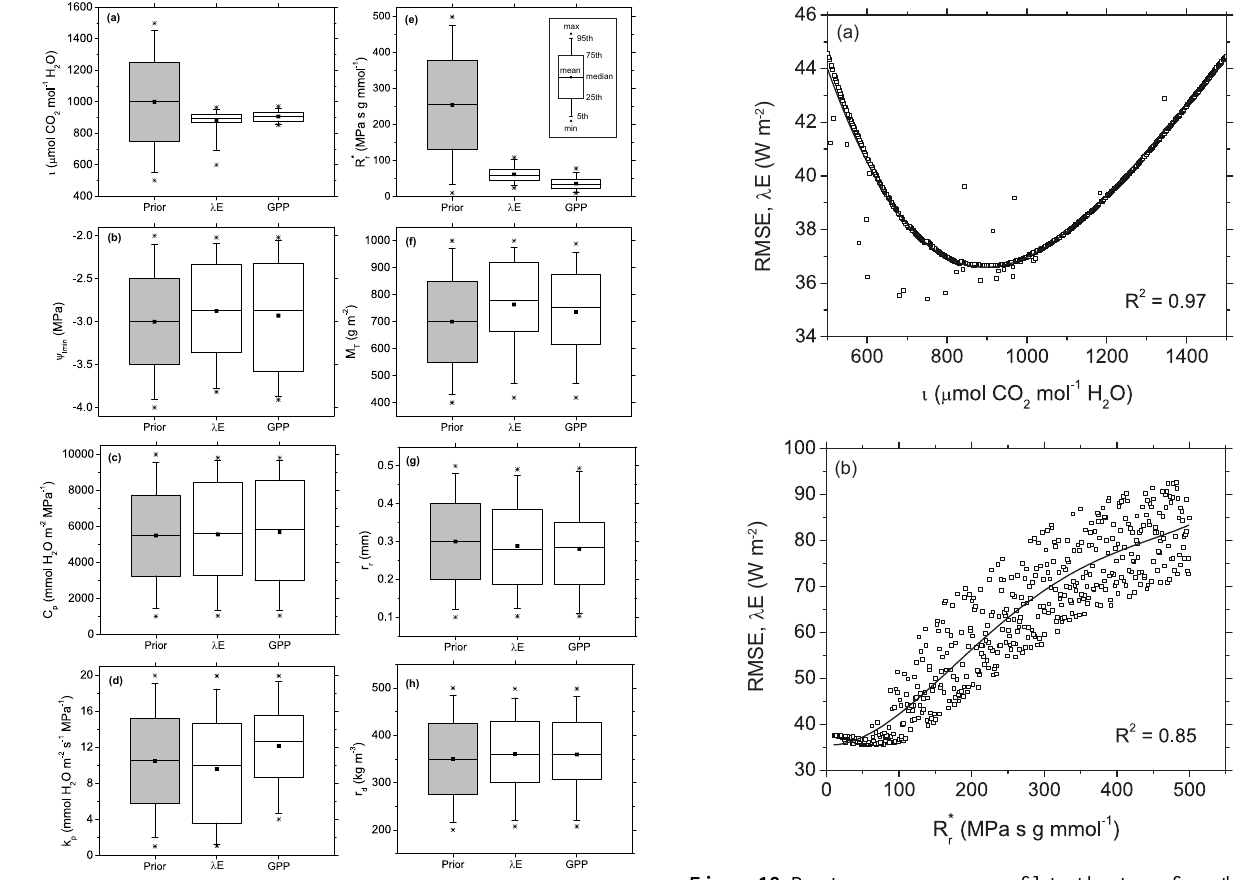
Figure 17. As in Fig. 15, but for SPA-WUE optimization. Parame- ters were generated from latin hypercube sampling ( m = 500 points with n = 4 variables). The left-hand panels (a–d) show prior and posterior values of the four aboveground stem and leaf parame- ters. The right-hand panels (e–h) show values of the four below- ground root parameters. For simulations with the lowest 10% error, RMSE = 35–37Wm − 2 and 4.08–4.20µmolCO 2 m − 2 s − 1 .